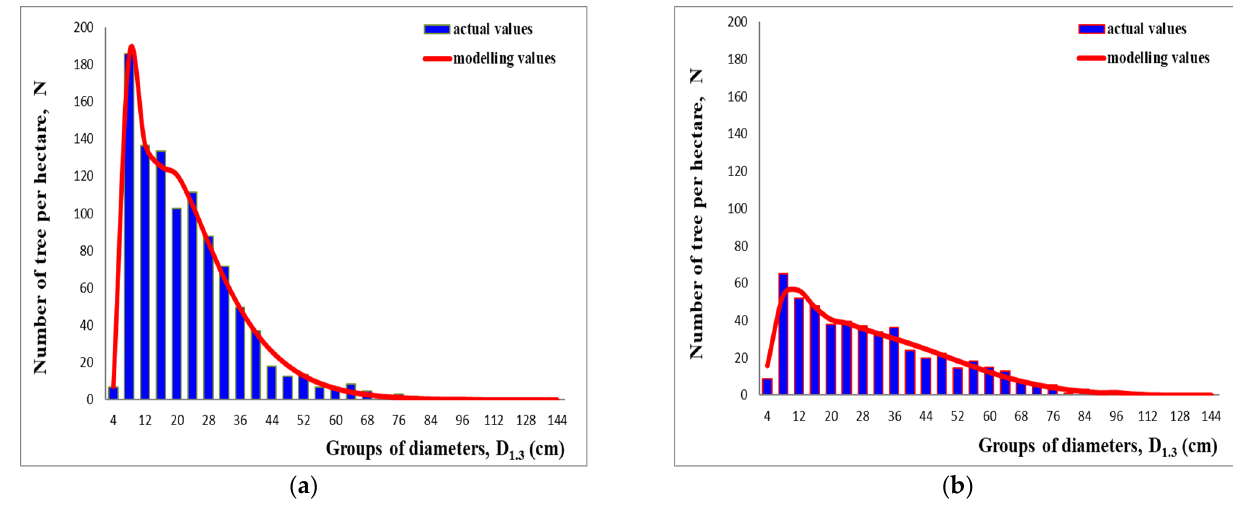
Figure 2. Differentiation of trees by groups of diameters: ( a ) Nature Reserve “Gorgany”; ( b ) National Natural Park “Skole Beskids”.